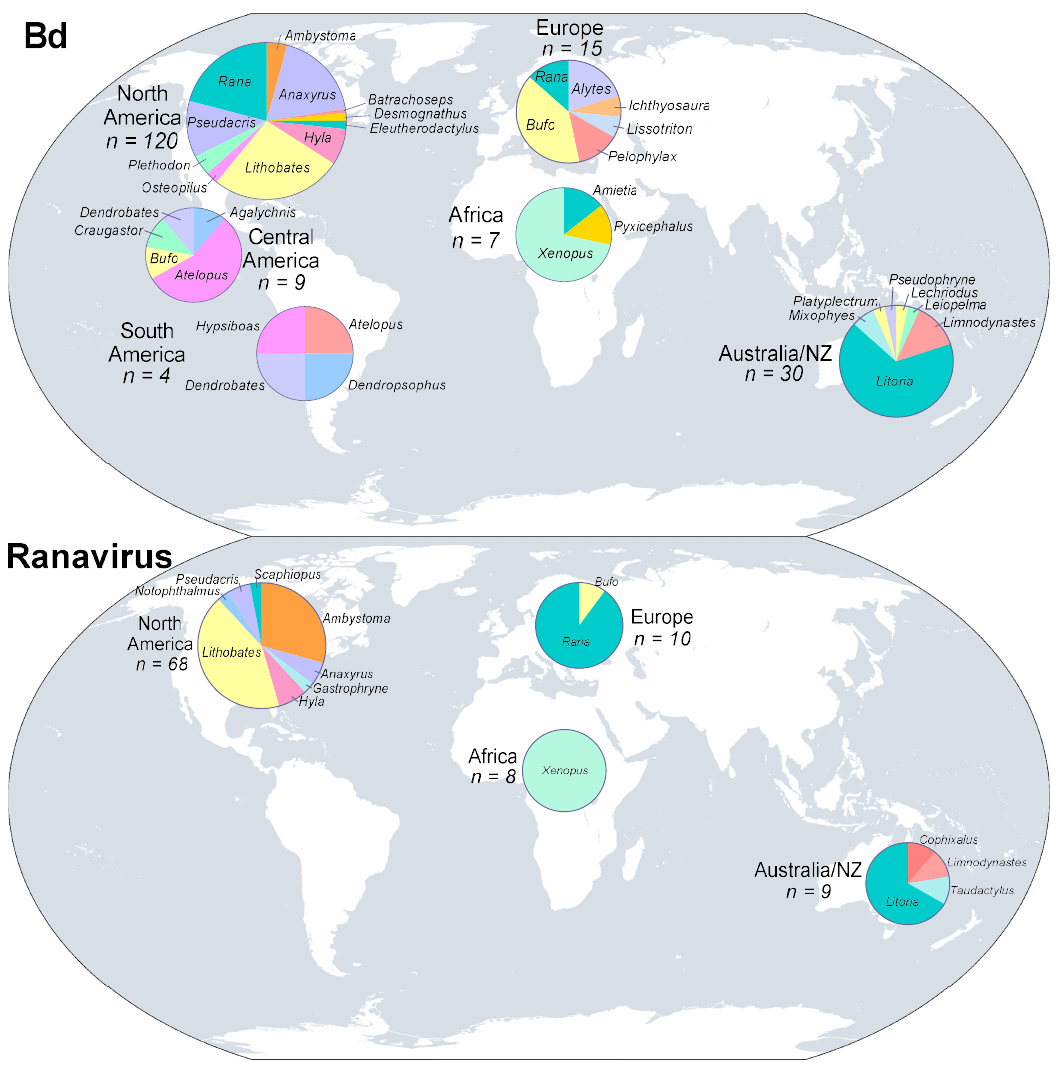
Figure 8. Experimental studies published on Bd and Rv with respect to amphibian host genus and geographic range. Methods to generate the number of studies were produced in the same fashion as explained in Table 1. N indicates the number of studies for a particular region.